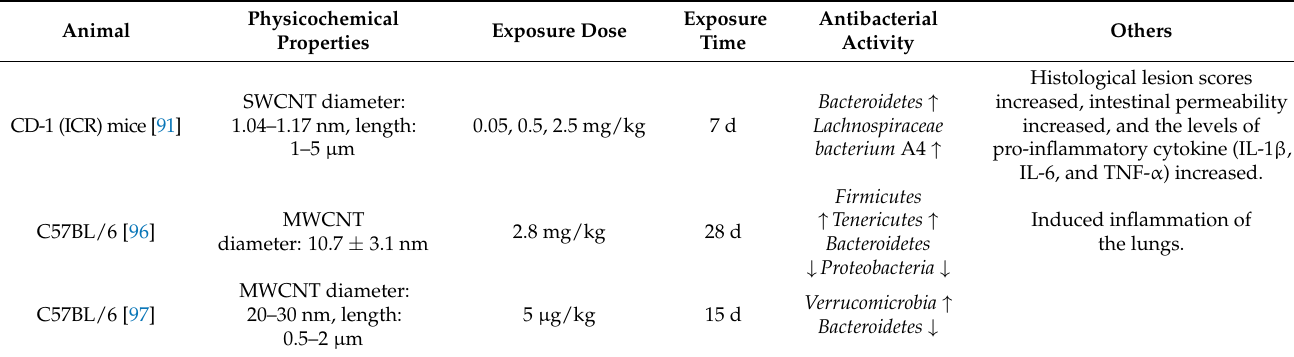
Table 4. Effects of CNMs on gut microbiota.